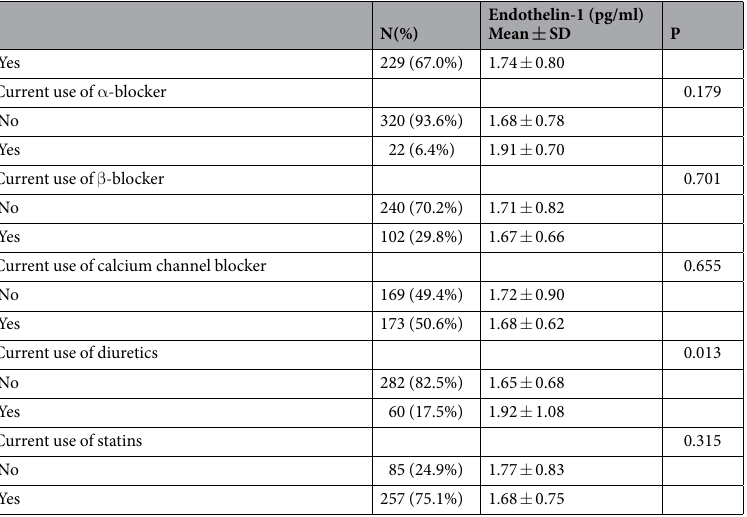
Table 2. Serum endothelin-1 levels in patients stratified by associated risk factors. ACE = angiotensin- converting enzyme, ARB = angiotensin II receptor blocker, BMI = body mass index, CI = confidence interval, CRP = C-reactive protein, HDL = high-density lipoprotein, LDL = low-density lipoprotein, MetS = metabolic syndrome. * Cutoff value based on the median.